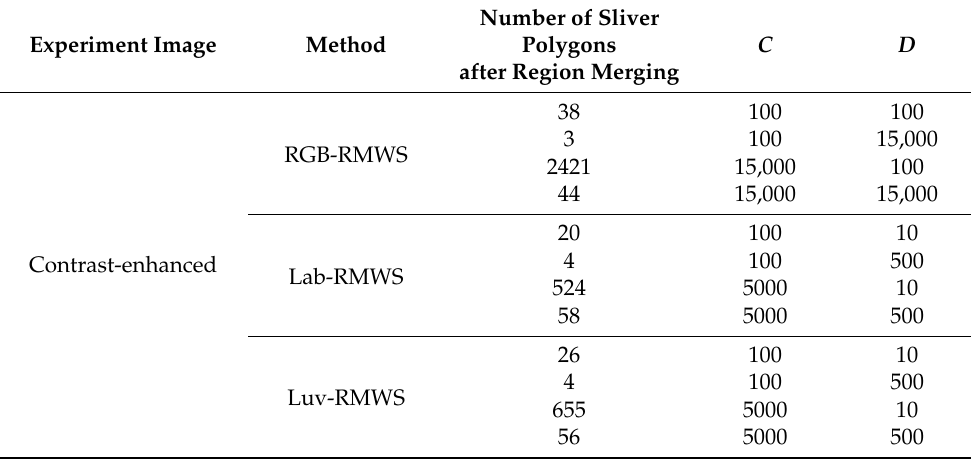
Table 3. Statistical features derived from the combinations of different C and D values.